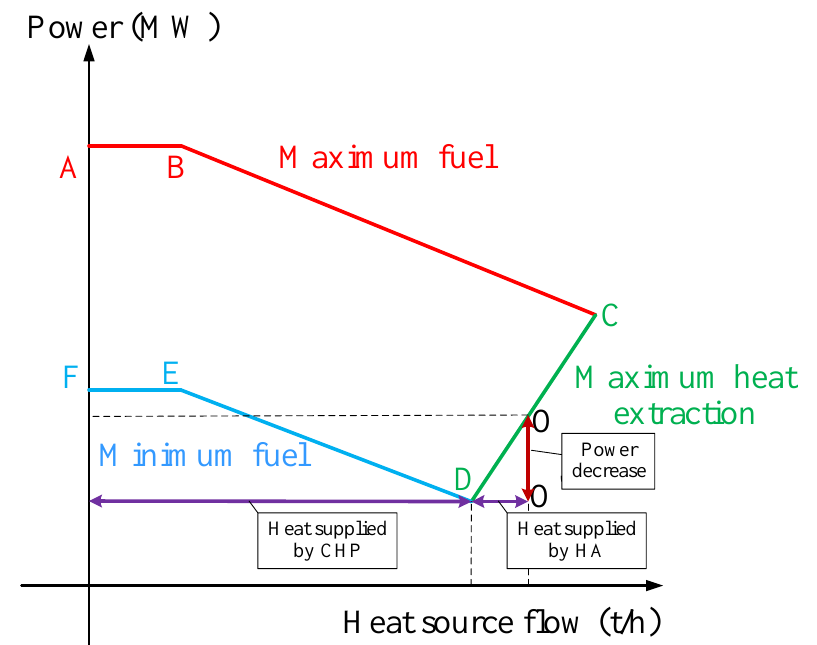
Figure 2. Diagram of reducing power production of CHP units through HA.